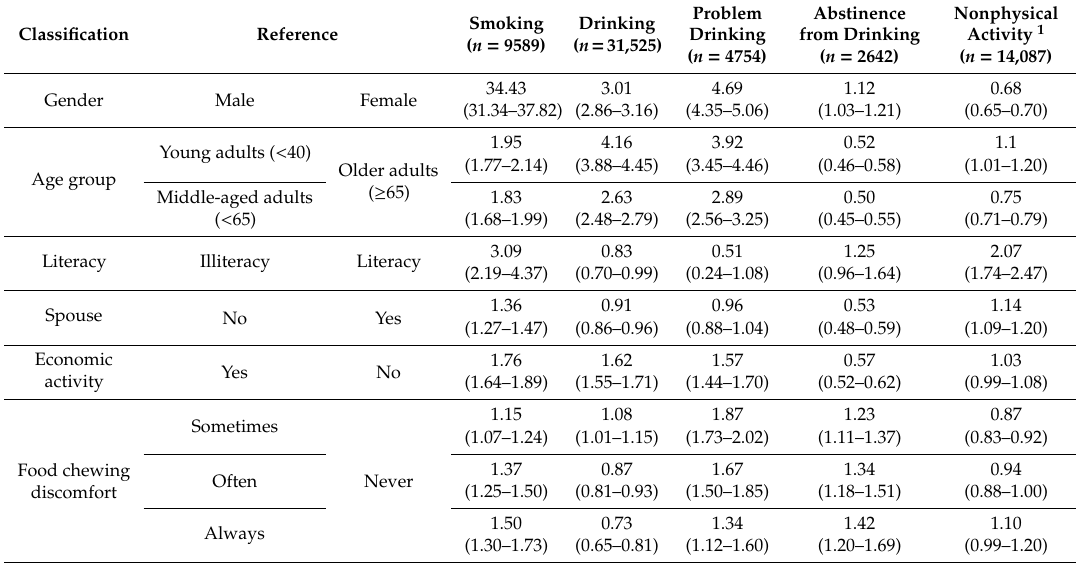
Table 5. Odds ratios of health behaviors by food-chewing discomfort through multiple logistic